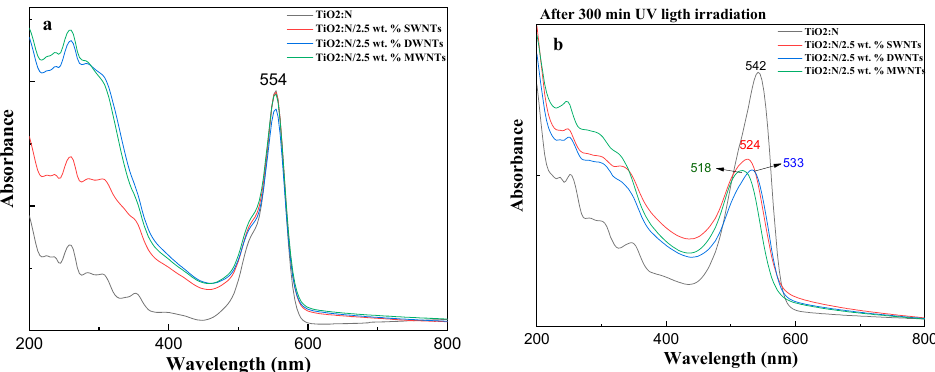
Figure 9. The UV–VIS spectra of the RhB aqueous solutions containing the T, S2, D, and M samples, before ( a ) and after ( b ) to exposure to UV light time of 300 min.